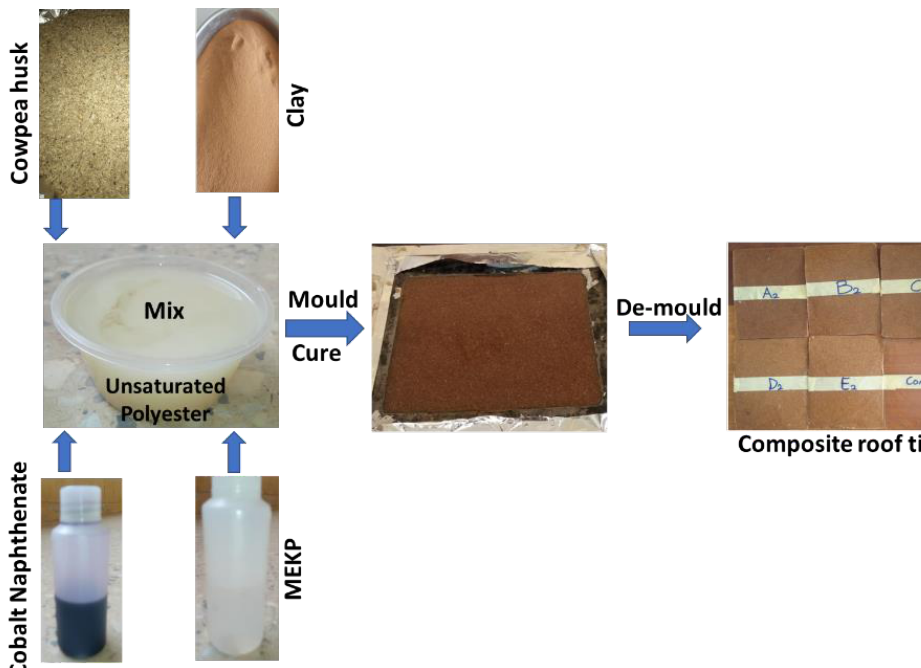
Figure 1. Graphical description of the research method. Table 1. Experimental design of